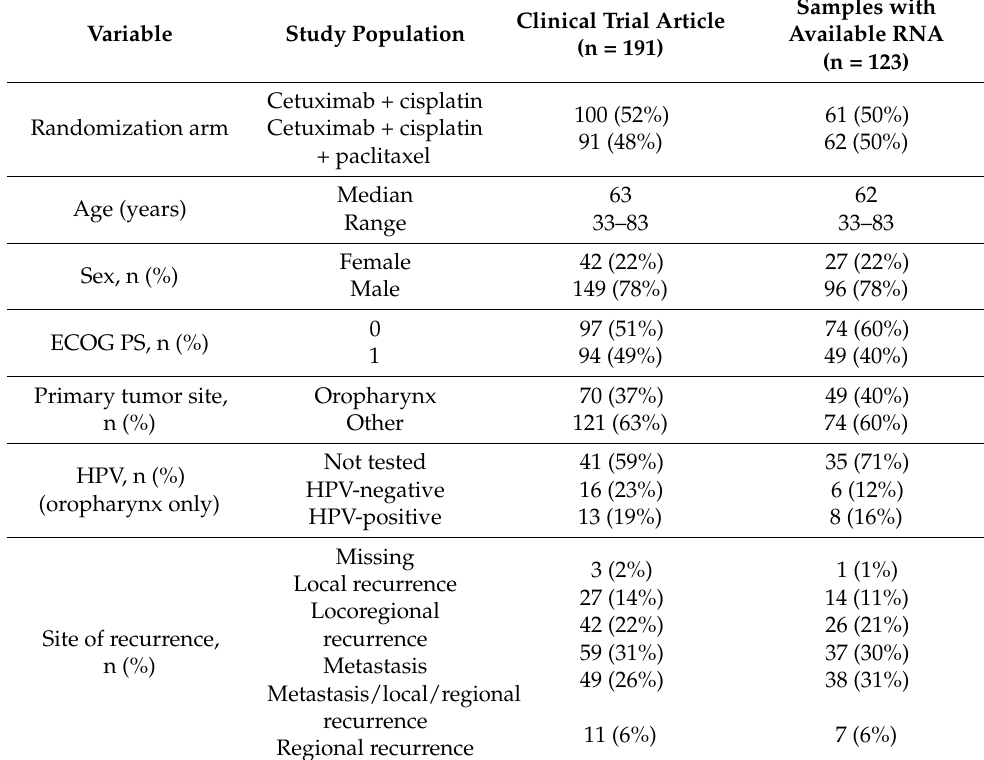
Table 1. Clinical-pathological characteristics of B490 study (n = 191) compared to the cohort consid- ered in the current study with available RNA (n = 123) that was analyzed for gene expression. Samples with Clinical Trial Article Available RNA Variable Study Population (n = 191) (n = 123) Cetuximab + cisplatin Randomization arm Cetuximab + cisplatin +